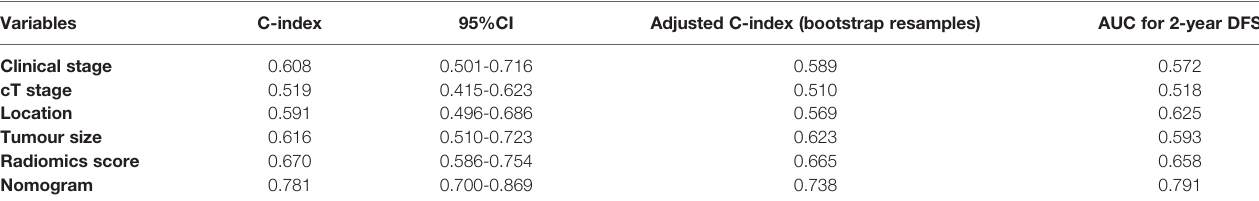
TABLE 3 | C-index and AUC of radiomics score-based nomogram and clinical